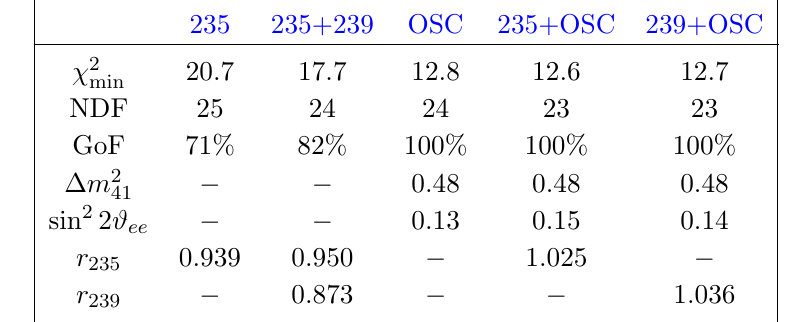
Table 2 . Fits of the reactor rates in table 1 of ref.